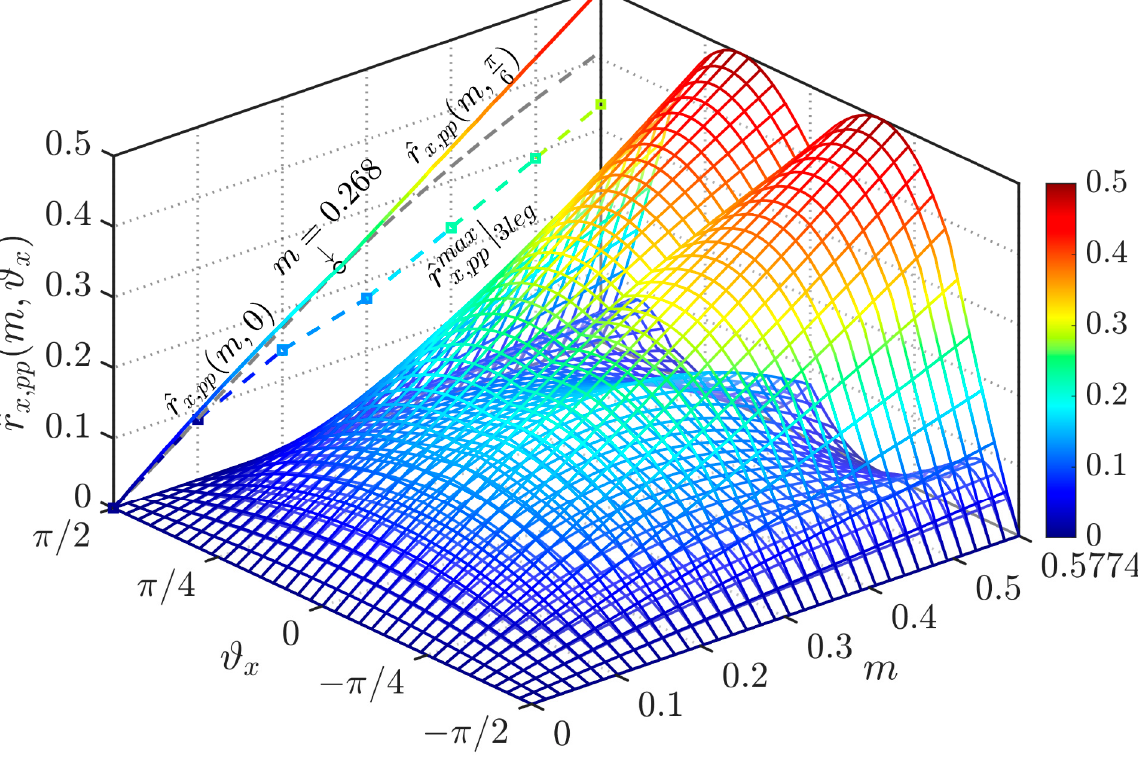
Figure 8. Normalized primary (upper) and secondary (lower) peak-to-peak phase current ripples in case of CPWM.